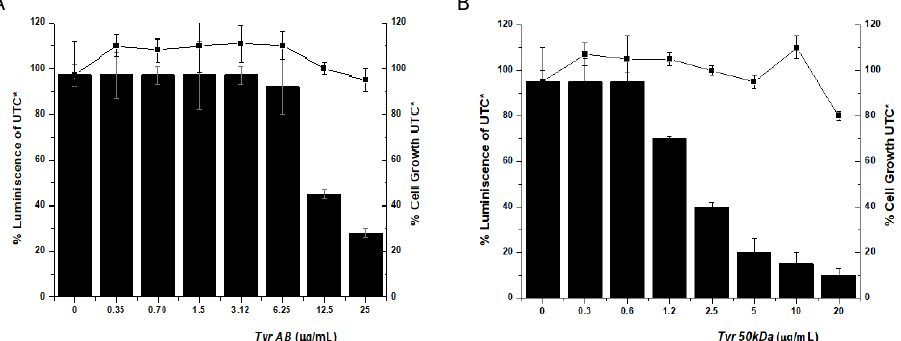
Figure 5. Inhibition of the hepatitis C virus (HCV) replicon in cell assays. Evaluation of the potency and cytotoxicity of pure isoforms in cell (Huh-5-2) assays. HCV replicon replication rate (luminescence, black bars) and cell survival (closed squares) were independently measured in cell culture by increasing protein concentration to determine EC 50 for ( A ) purified TyrAB and ( B ) purified Tyr50 kDa. * All luminescence and viability values were normalized considering the untreated control values